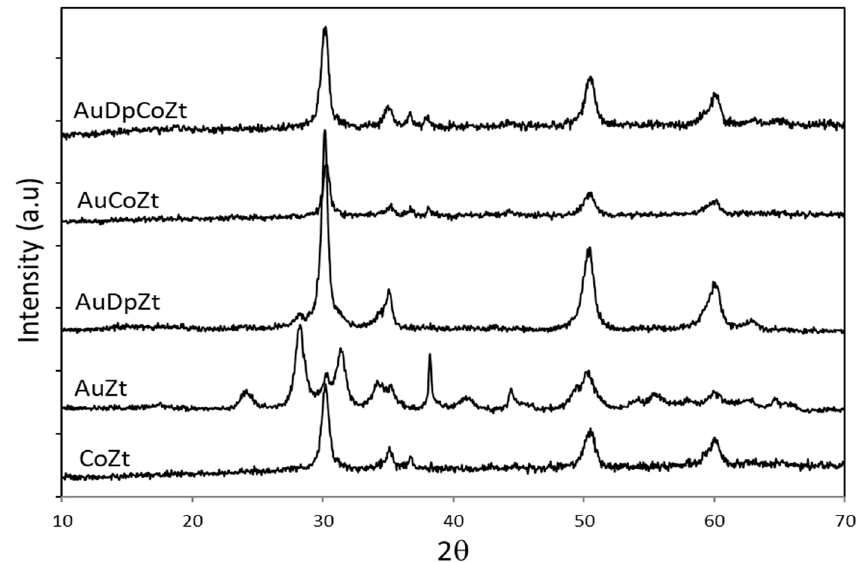
Figure 3. XRD patterns of catalysts supported on Zt zirconia.